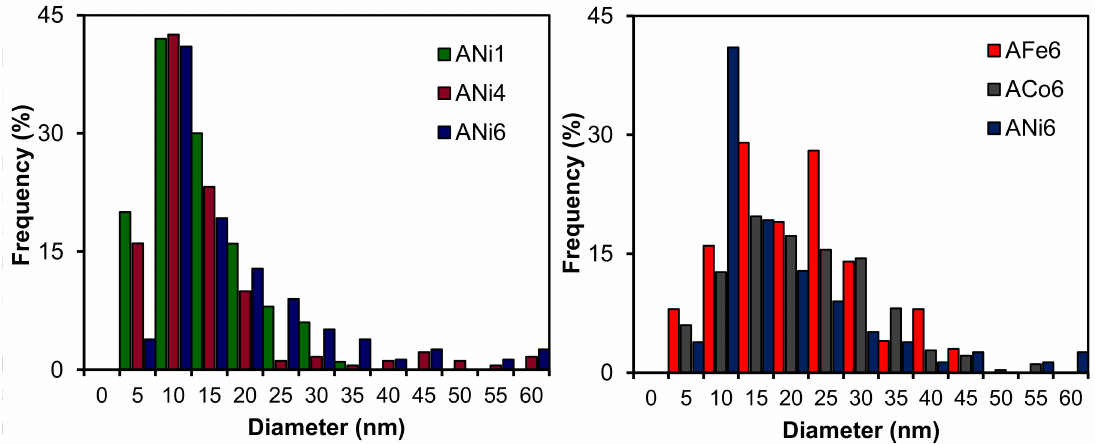
Figure 4. Particle size distributions obtained from HRTEM